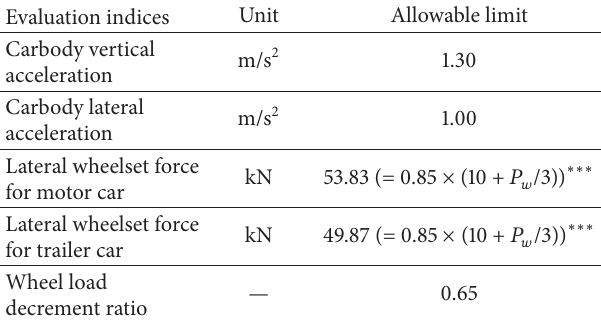
Table 6: Evaluation standards for train operation stability.